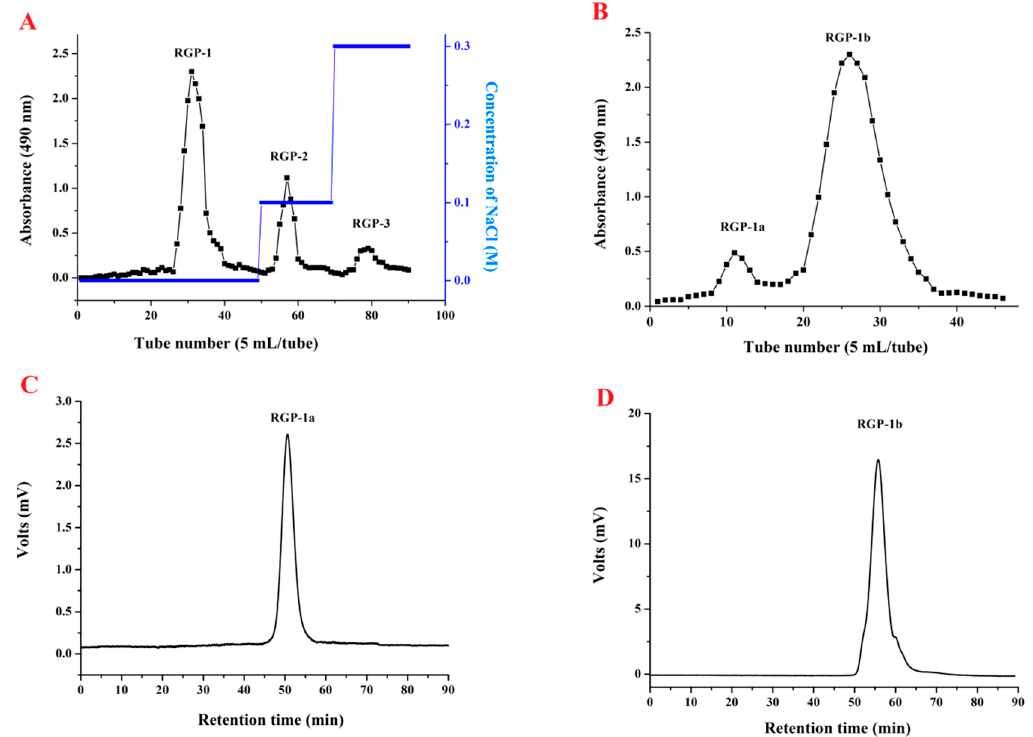
Figure 2. ( A ) Elution curve of crude RGP on DEAE-cellulose column; ( B ) elution curve of RGP-1 on Sephadex G-100 column; ( C ) HPGPC spectra of RGP-1a and ( D ) RGP-1b.